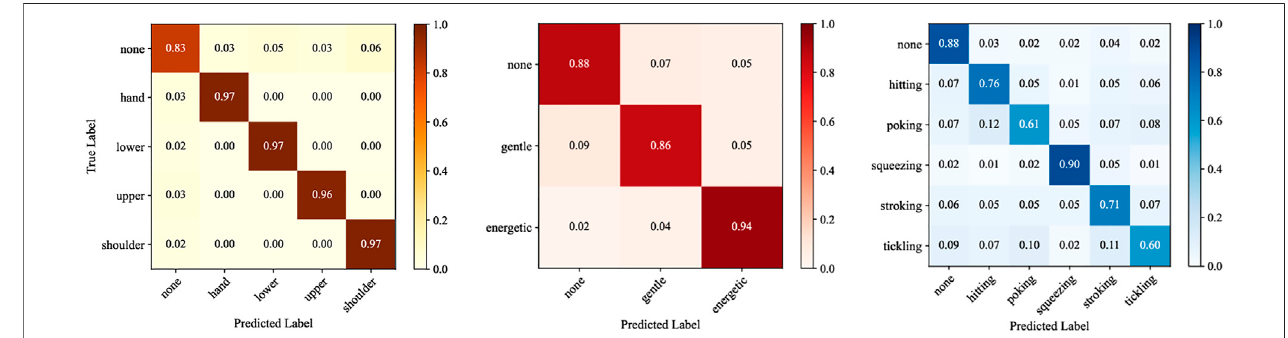
FIGURE 4 | Normalized confusion matrices showing the classi fi cation results for location, force intensity, and gesture.